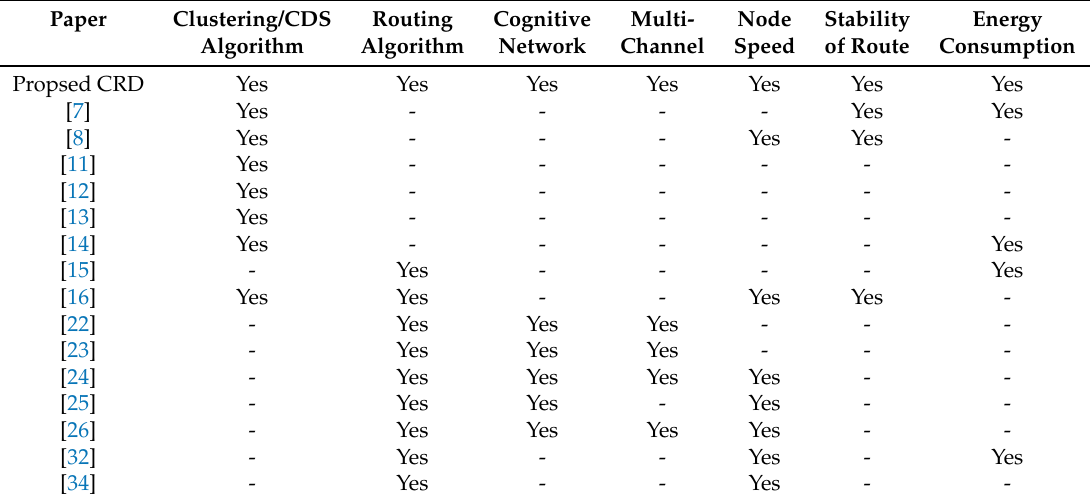
Table 1. Comparison of proposed protocol (CRD) with other